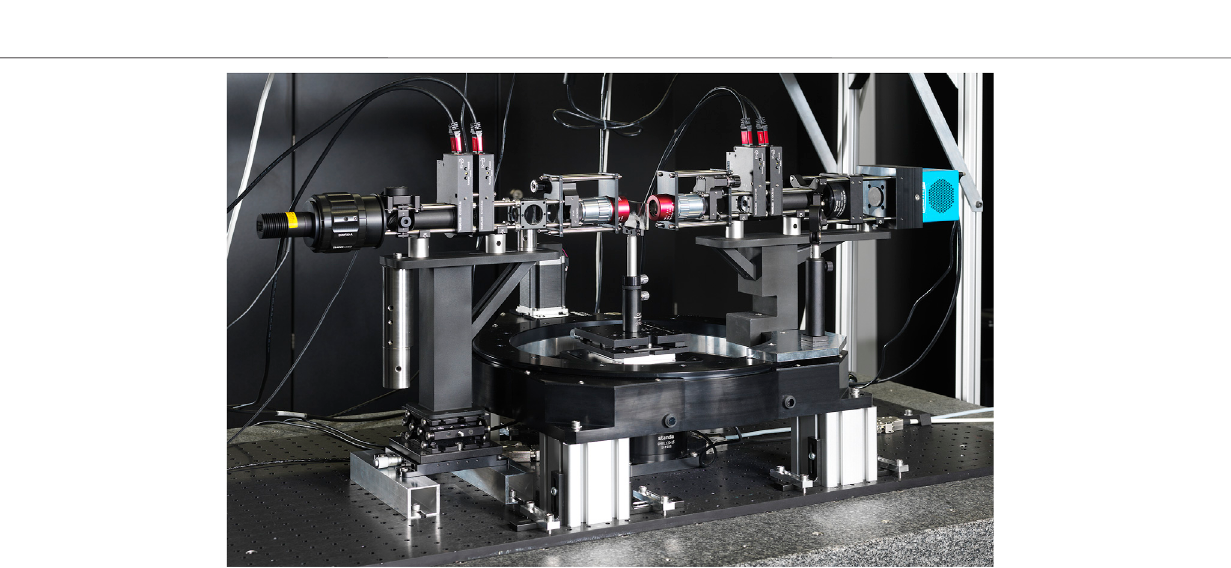
FIGURE 1 | Imaging Mueller matrix ellipsometry setup, top view sketch. P: polarizer, λ /4: quarter-wave plate.